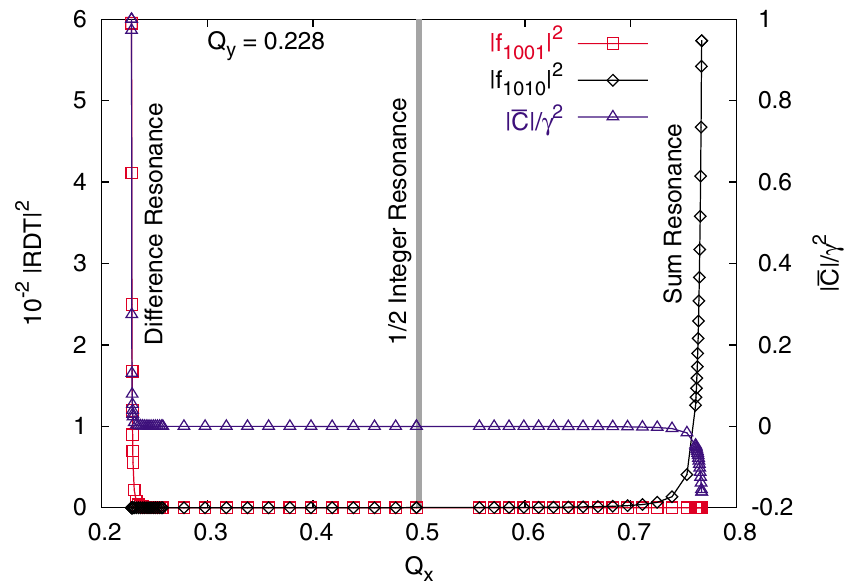
j 2 , j f j 2 , and j C j =(cid:20) 2 plotted as a function of Q FIG. 3. (Color) j f 1001 1010 resonance show the dramatic increase in these functions. The 1 = 2 integer resonance line is plotted as a reference.